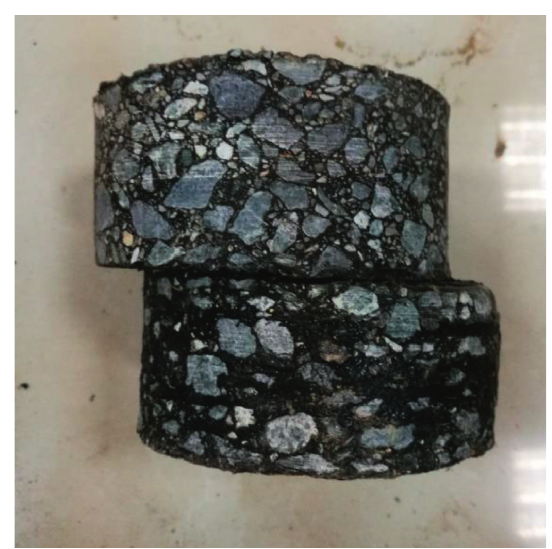
Figure 3: Sample destruction form.